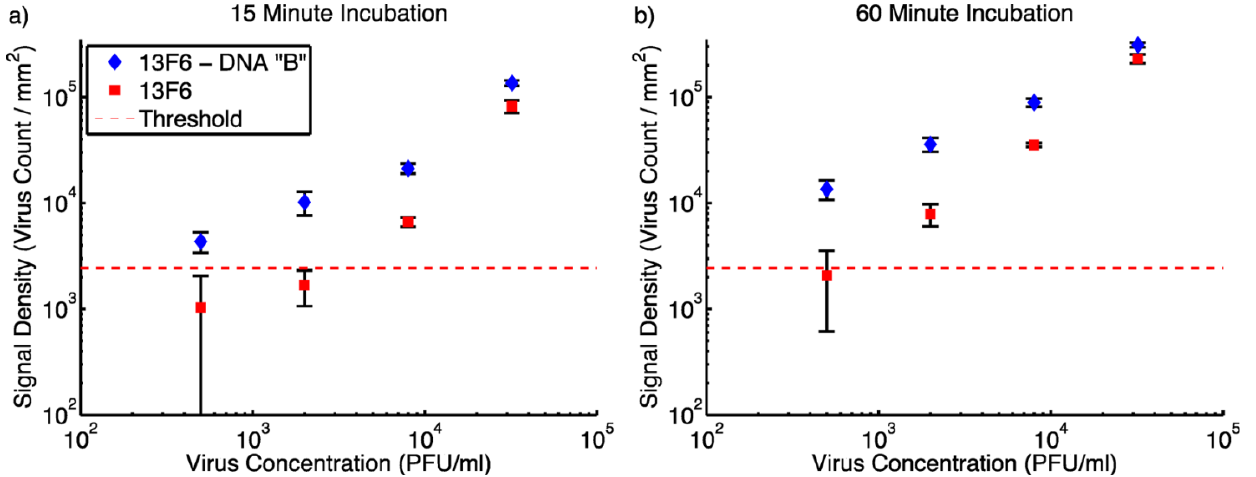
Figure 6. Comparison of the detection efficiency of directly immobilized VSV-pseudotyped EBOV antibodies with DNA-conjugated types. The measurement of signals obtained by captured viruses with SP-IRIS at different virus concentrations after ( a ) 15 min incubation ( b ) 60 min incubation [44]. Reproduced with permission from E. Seymour, G.G. Daaboul, X. Zhang, S.M. Scherr, N.L. Ünlü,